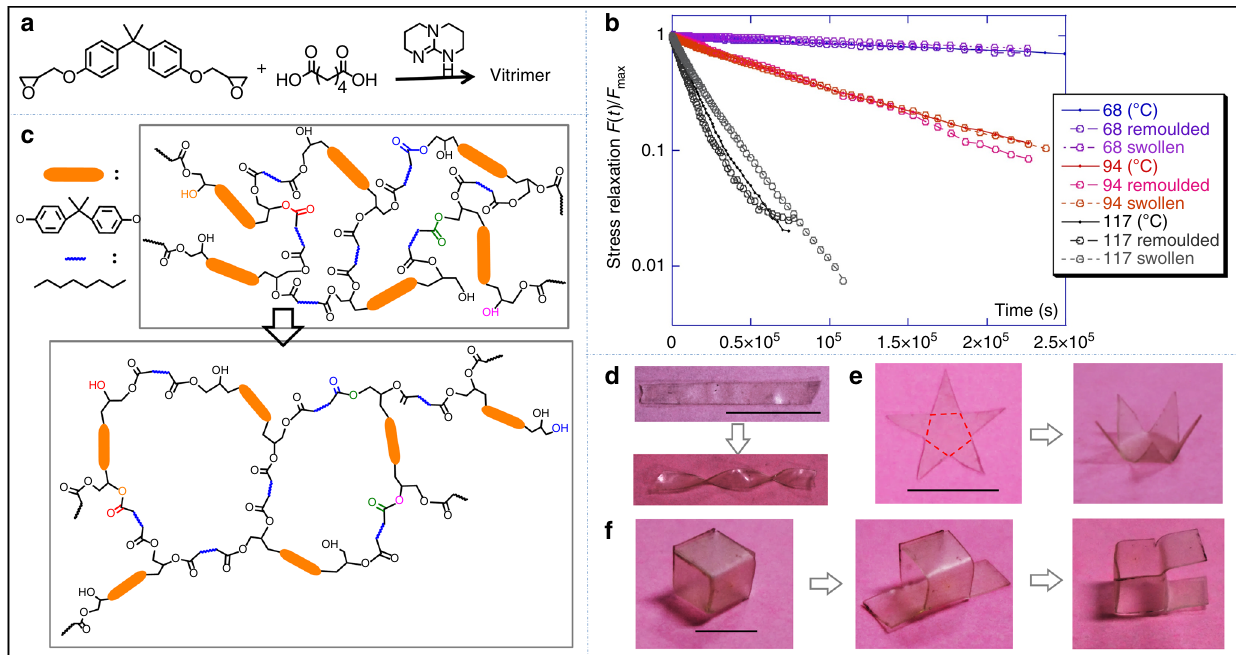
Fig. 4 The mechanism of solvent-induced transesteri fi cation. a Synthesis of epoxy vitrimer. b Stress-relaxation curves for transesteri fi cation at three different temperatures (labeled on the plot), making a comparison between the original network, the thermally remolded one, and the network that was dried after extensive swelling (con fi rming that its BER remains the same). c An illustration of transesteri fi cation when swelling in solvent. d Reshaping a strip to a spiral by solvent under external force. Scale bar: 1 cm. e Reshaping a star with external force. Scale bar: 1 cm. f Reshaping a cube vitrimer by depositing solvent onto the designed edges and folding/unfolding with external force simultaneously in each procedure. Scale bar: 1